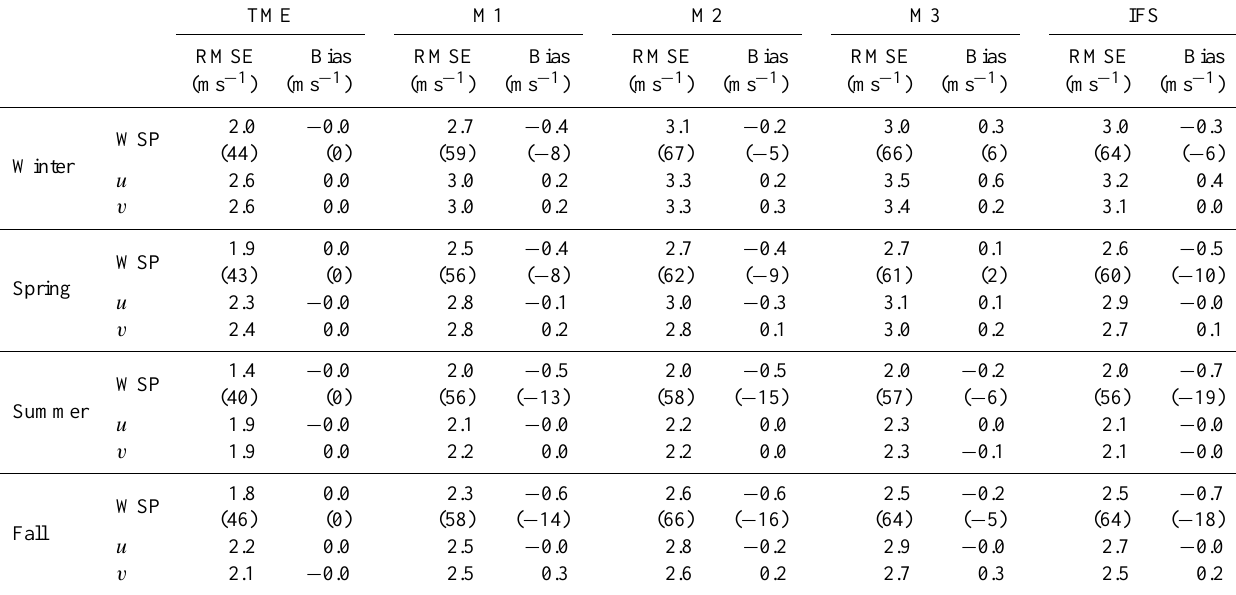
Table 2. RMSE and bias for the TME and for each single model for the four seasons. Scores are relative to the wind speed (WSP) and to the zonal and meridional wind components. The scores of the IFS model are reported as reference. Values in parentheses show the error in percentage of the seasonally averaged wind